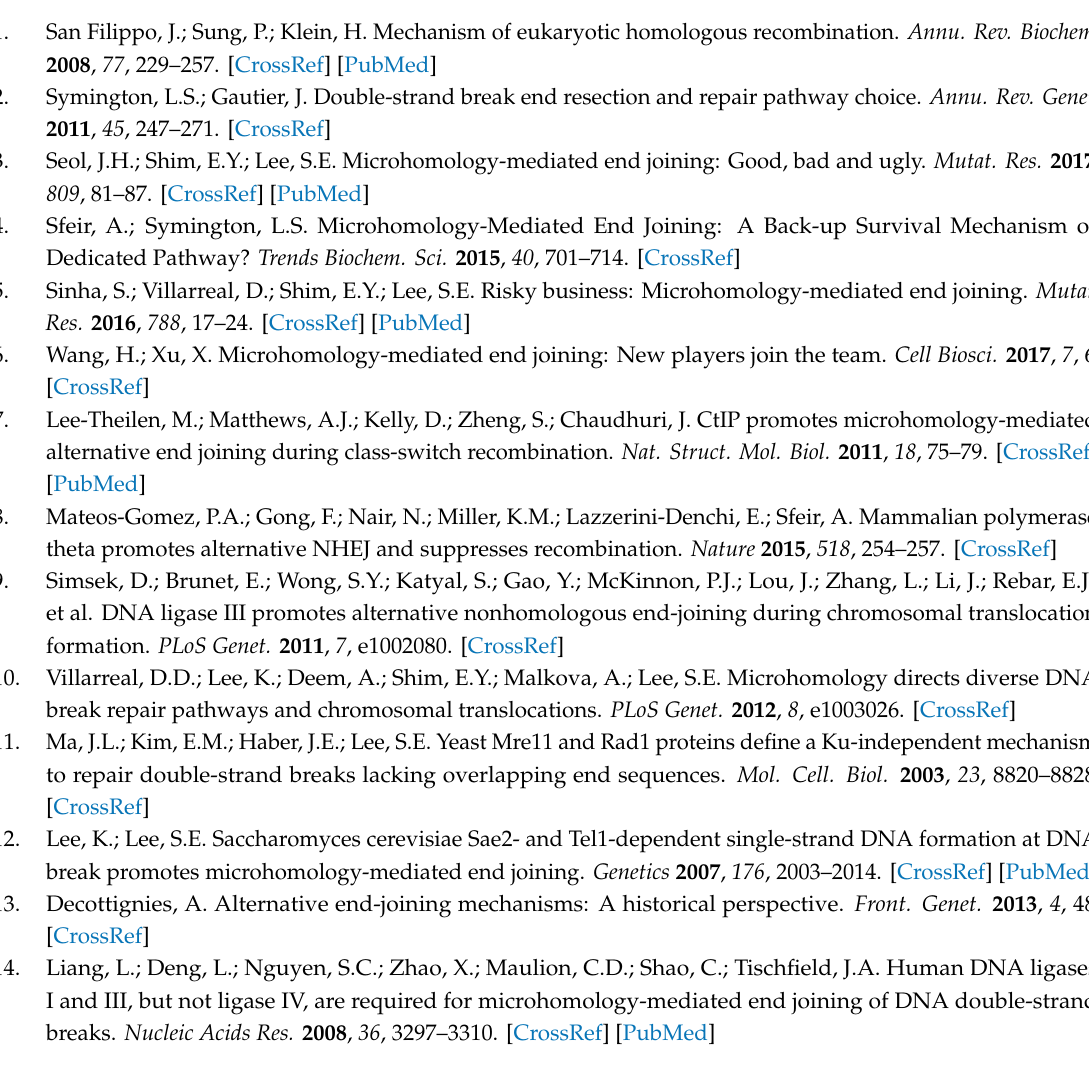
Figure S1: Distribution of 12-mer microhomology pairs flanking HO cleavage